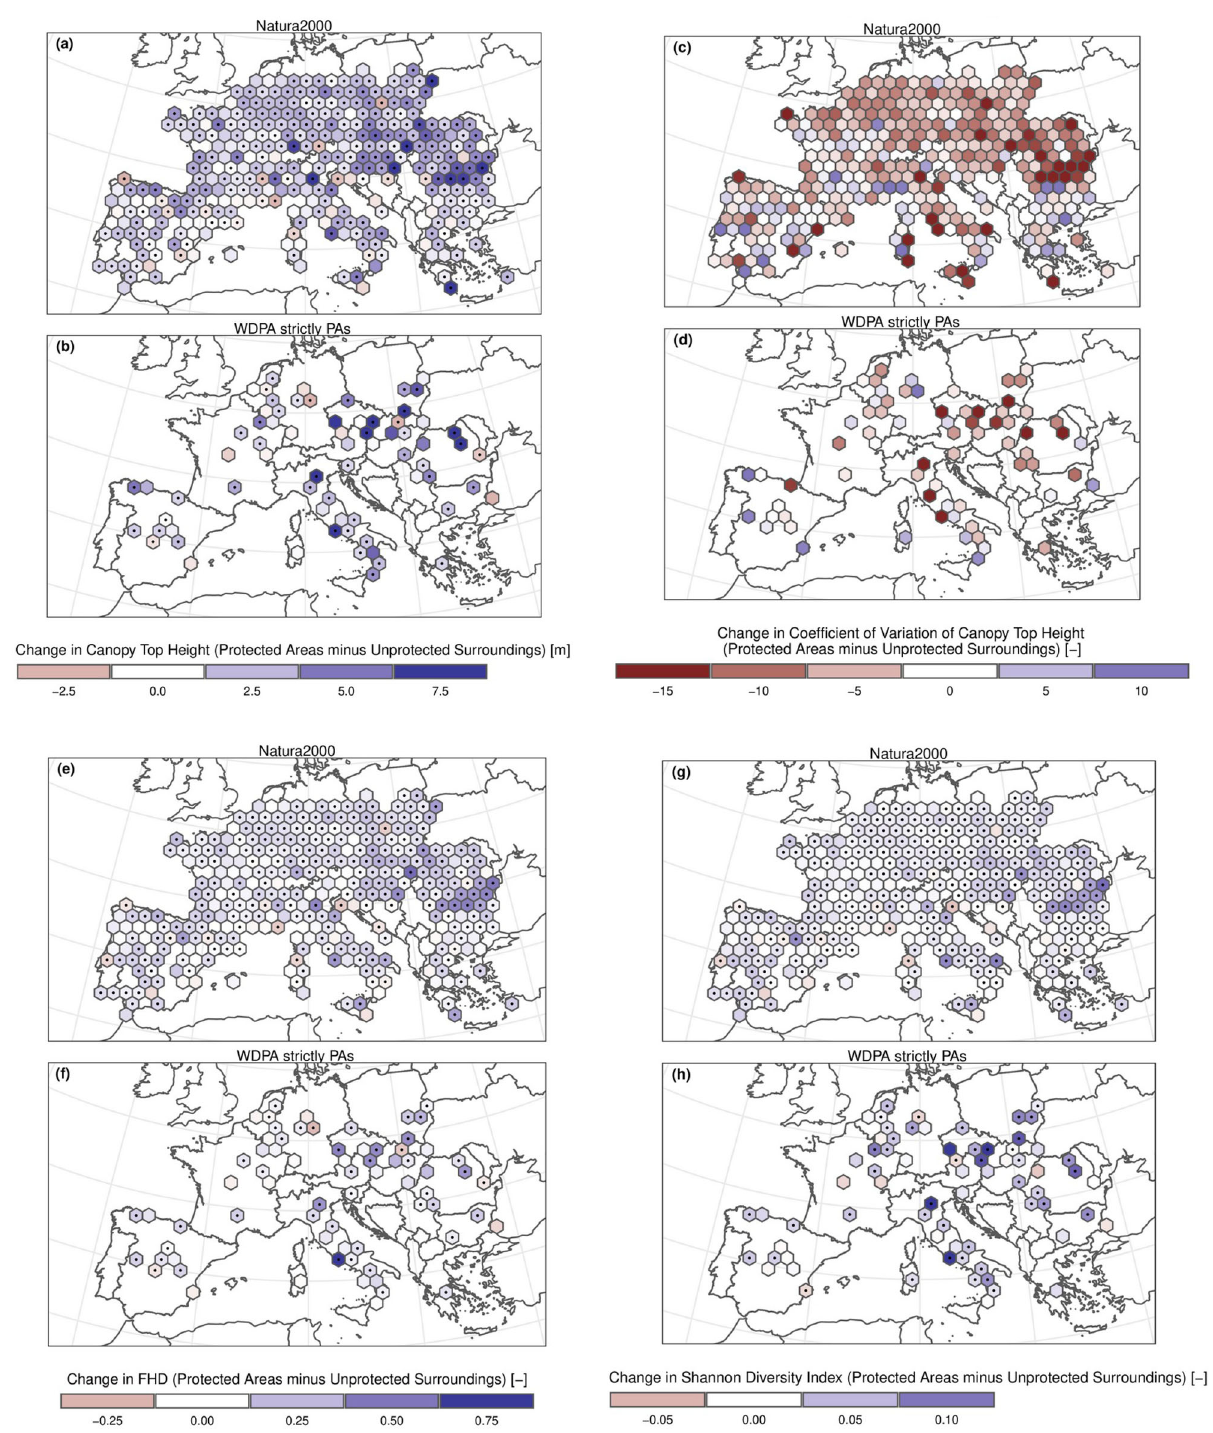
Fig. 1 Differences between Protected Areas and Unprotected Surroundings. Difference in Canopy Top Height between Protected Areas and Unprotected Surroundings for ( a ) Natura 2000 sites and ( b ) strictly protected sites according to the World Database on Protected Areas (WDPA). Difference in coef fi cient of variation of canopy top height ( c , d ), Foliage Height Diversity ( e , f ) and Shannon Diversity Index ( g , h ). Within each hexagon grid cell (side 100 km), we computed the mean values - and the coef fi cient of variation - of canopy top height in Protected Areas and Unprotected Surroundings and then their difference. Grey- fi lled colour identi fi es EU countries where concurrent PAs and GEDI information is available. Note that Croatia does not appear in the WDPA because the protection classi fi cation is missing for its PAs. Dots in the hexagons indicate when differences are statistically signi fi cant (i.e. p < 0.05) using a t-test with Bonferroni correction (not performed for the coef fi cient of variation of canopy top height). Density plots of the differences ( i – l ) for Natura 2000 sites (blue fi lled) and strictly protected sites according to the World Database on Protected Areas (yellow fi lled - WDPA). The vertical solid line represents the mean value, while the vertical dot-dashed lines the standard